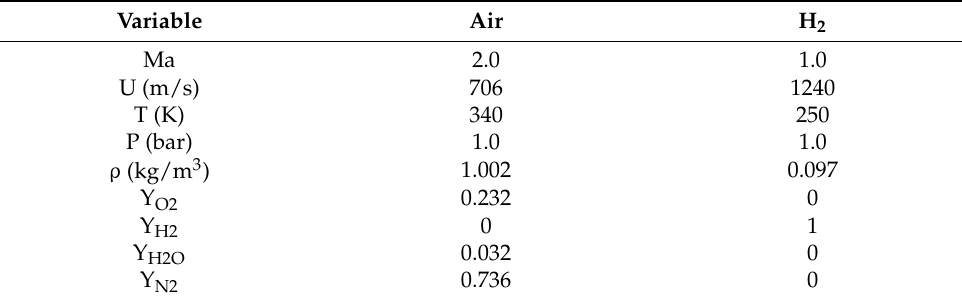
Figure 1. Schematic layout of 2D scramjet combustor models. Table 1. Inflow conditions of air and